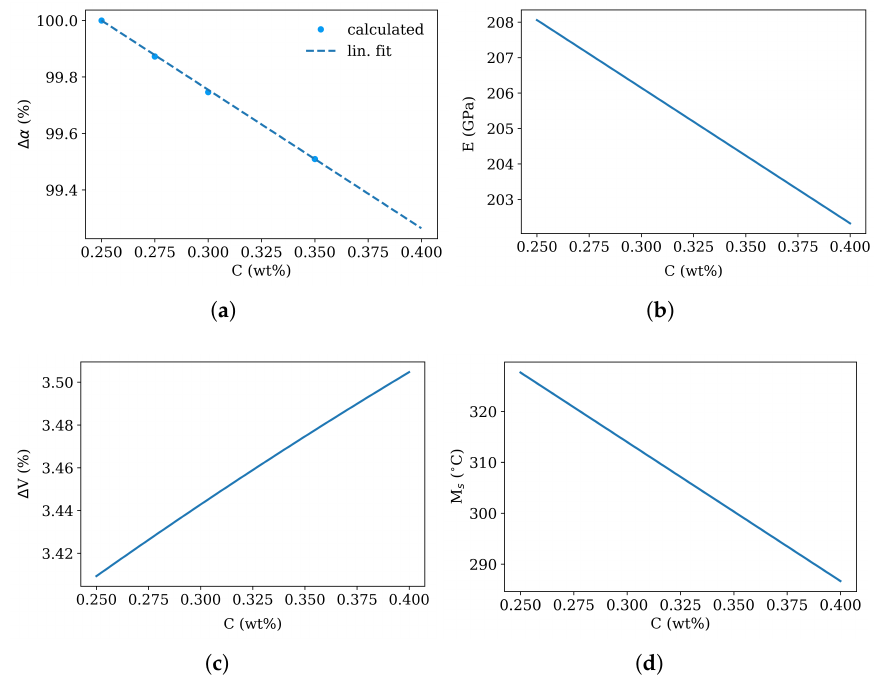
Figure 5. Dependency of difference in thermal expansion coefficient ∆ α (JMatPro, [23]) and metallur- gic volume expansion ∆ V ([22]) as function of carbon content as well as Young’s modulus E ([16]) and martensite start temperature M s ([21]) as function of carbon